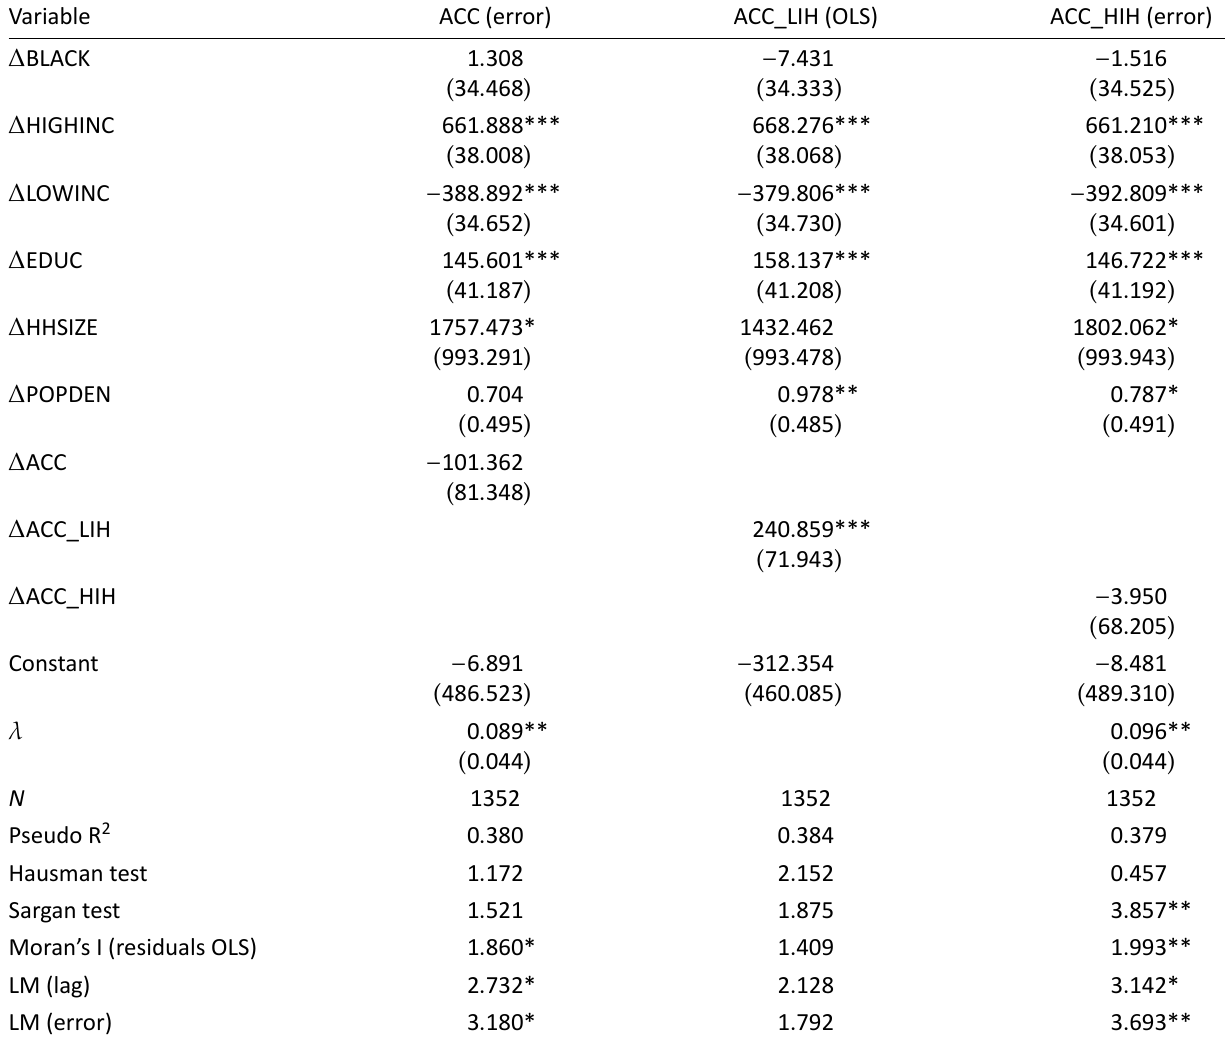
Table 3. Estimation results for changes in median household income ($) using spatial error and OLS.